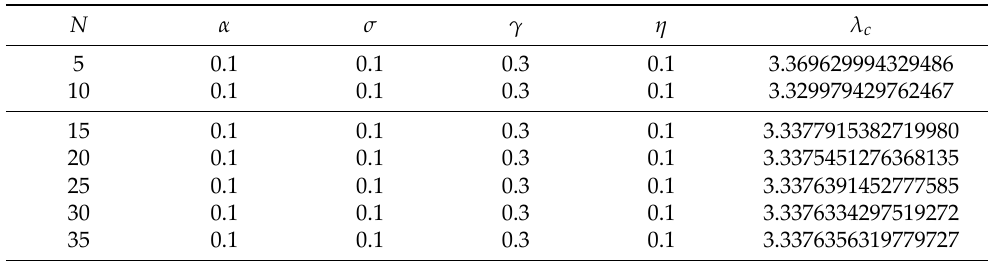
Table 3. Fast convergence of critical values by weighted residual method when Gr = 3, δ = 0.2, Bi 1 = 10 = Bi 2 , m = 0.5, ε = 0.1 .